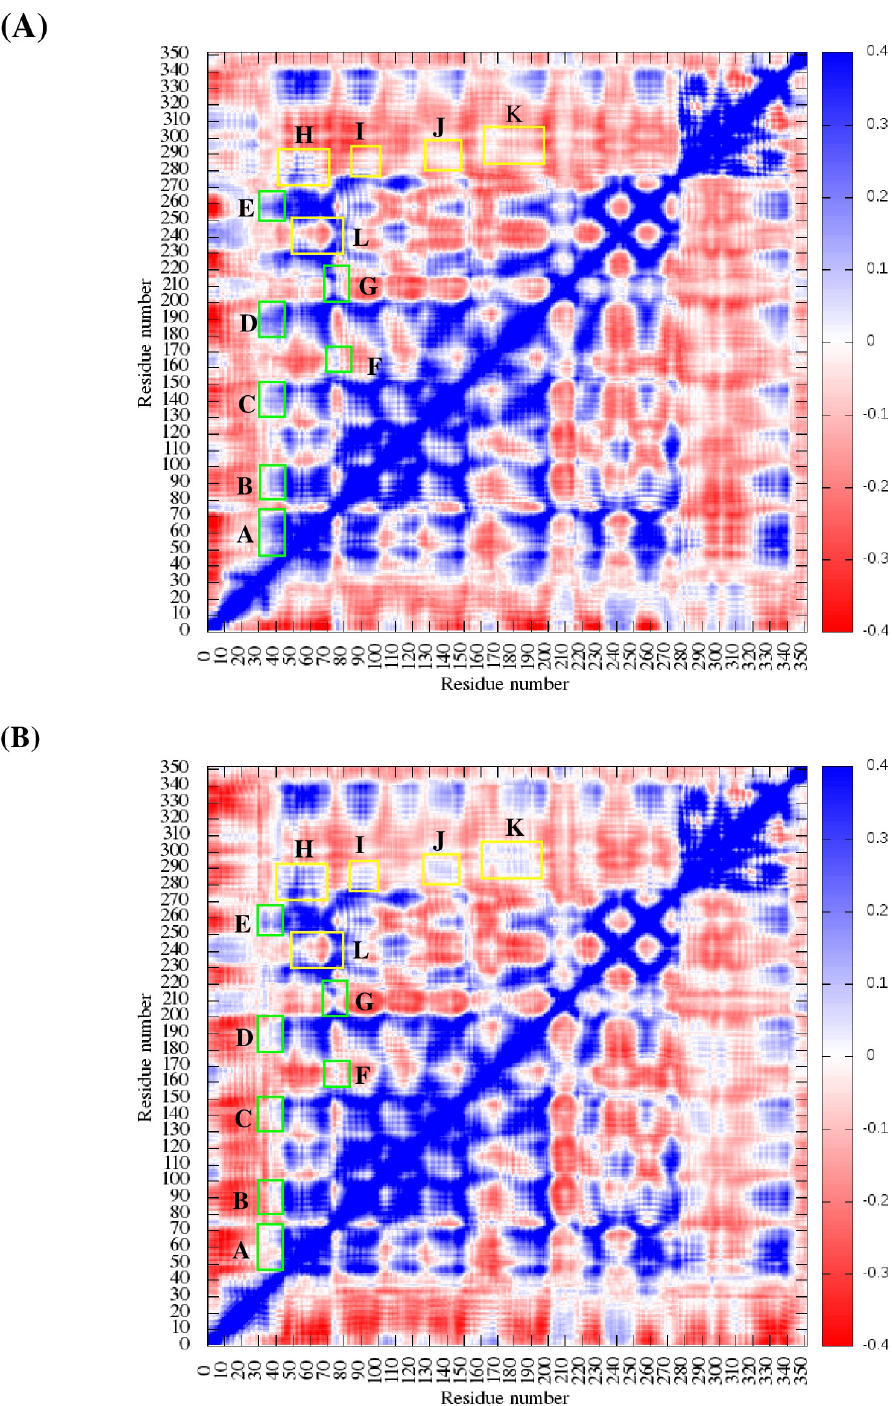
Fig 7. Intrachain cross correlation maps. Plot for (A) the native structure and (B) the L53Q mutant, areas with decreased and increased correlation are highlighted with green and yellow rectangles, respectively.